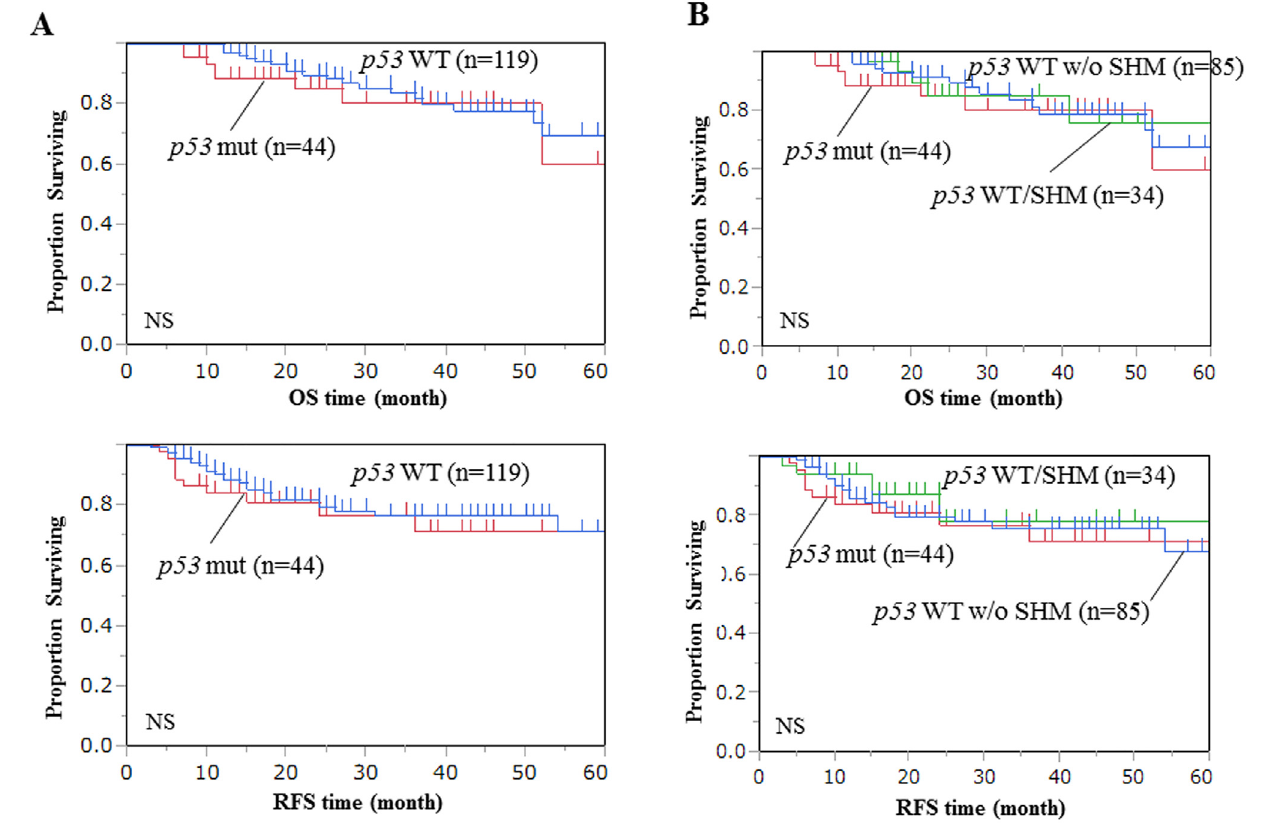
Fig 2. Kaplan Meier analysis of overall survival (OS) and relapse free survival (RFS) of primary gastric cancer patients with pathological stage II/III (pStage II/III) who underwent curative resection and postoperative adjuvant chemotherapy. (A) According to p53 gene mutation status and (B) according to the p53 aberration